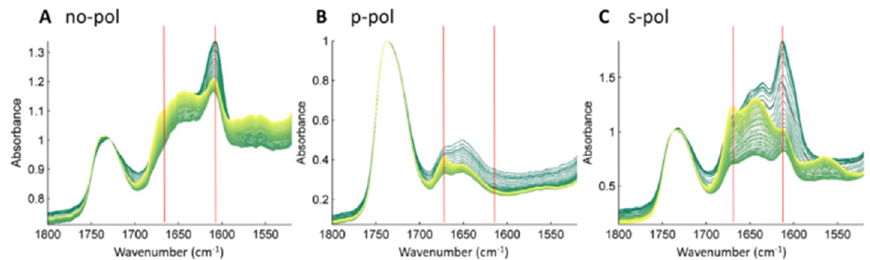
Figure 4. ATR-FTIR kinetics of the interaction between CTR amyloid fibrils and EPE lipids. ( A ): spectra without polarization; ( B ): with p-polarization, and ( C ): with s-polarization; The evolution of the spectra with the time is from dark-green to yellow, spectra are taken every 10 min for 15 h. The absorbance was normalized to 1 at 1730 cm − 1 . The band at 1610 cm − 1 , characteristic of amyloid fibrils, decreases during the interaction of the peptide with EPE lipids. The band at 1672 cm − 1 that increases during incubation is probably from residual TFA used for Hfq-CTR synthesis.